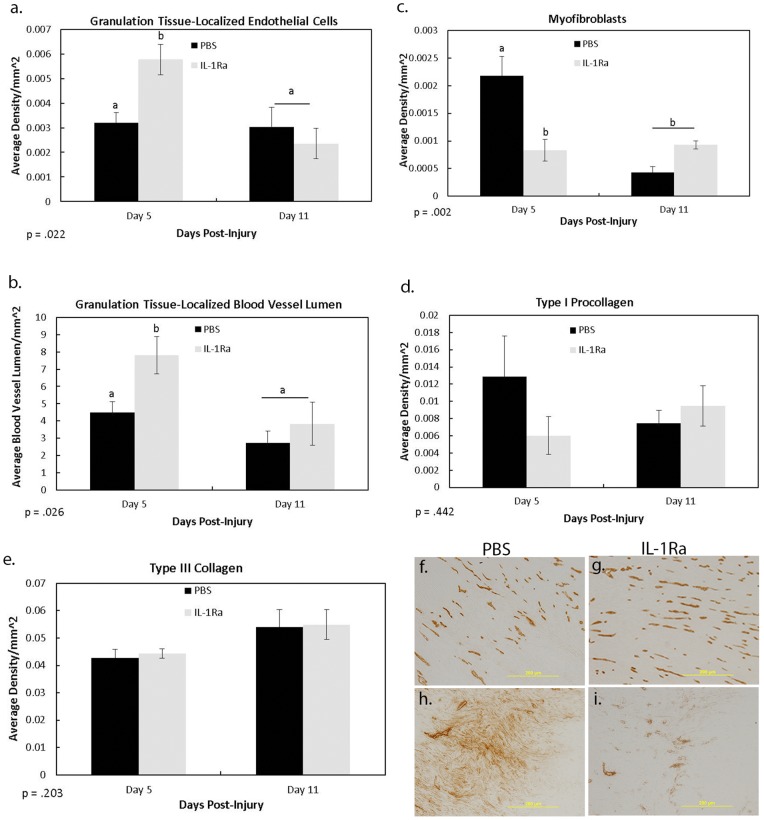
Immunohistochemistry results of cellular and ECM factors regulated by IL-1Ra.Immunohistochemistry results showing the effects of PBS and IL-1Ra on granulation tissue localized endothelial cells (a), granulation tissue-localized blood vessel lumen (b), total myofibroblasts (c), type I procollagen (d), and type III collagen (e) at 5 and 11 days post-injury. IL-1Ra significantly increased the number of endothelial cells and blood vessel lumen on day 5 (a–b), but not day 11. In contrast, IL-1Ra significantly decreased the number of myofibroblasts at day 5 (c). No differences within the MCL were observed on day 11 (c). Regardless of day, no treatment differences were observed with type I procollagen (d) and type III collagen (e). a,b indicates within a graph, bars without a common superscript letter differ (results of Fisher’s LSD post-hoc pairwise analysis, p<.05). Values are expressed as mean density ± S.E.M. Representative micrographs of endothelial cells/blood vessel lumen (f–g) and myofibroblasts (h–i) 5 days post-injury after PBS (left column) and IL-1Ra (right column) treatment.